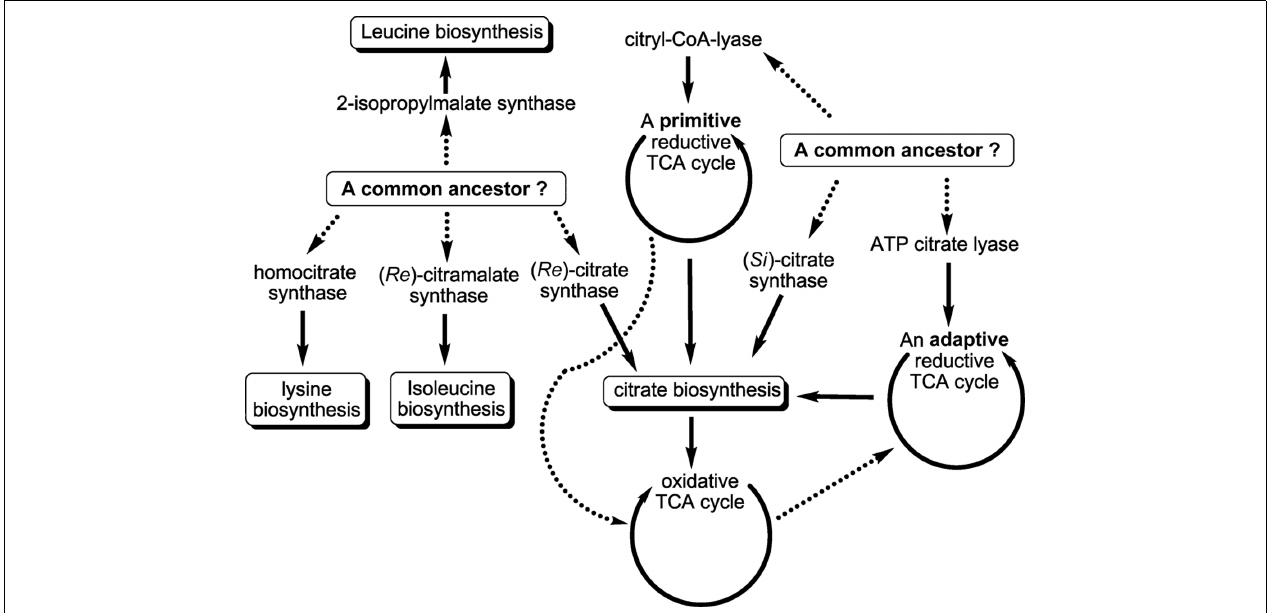
another common ancestor.The oxidativeTCA cycle was thought to have evolved from the primitive reductiveTCA cycle, whereas the reductiveTCA cycle operated in the GSBs has been proposed to be an adaptive form that may have evolved from the OTCA cycle.The proposed evolutionary links are shown in dashed